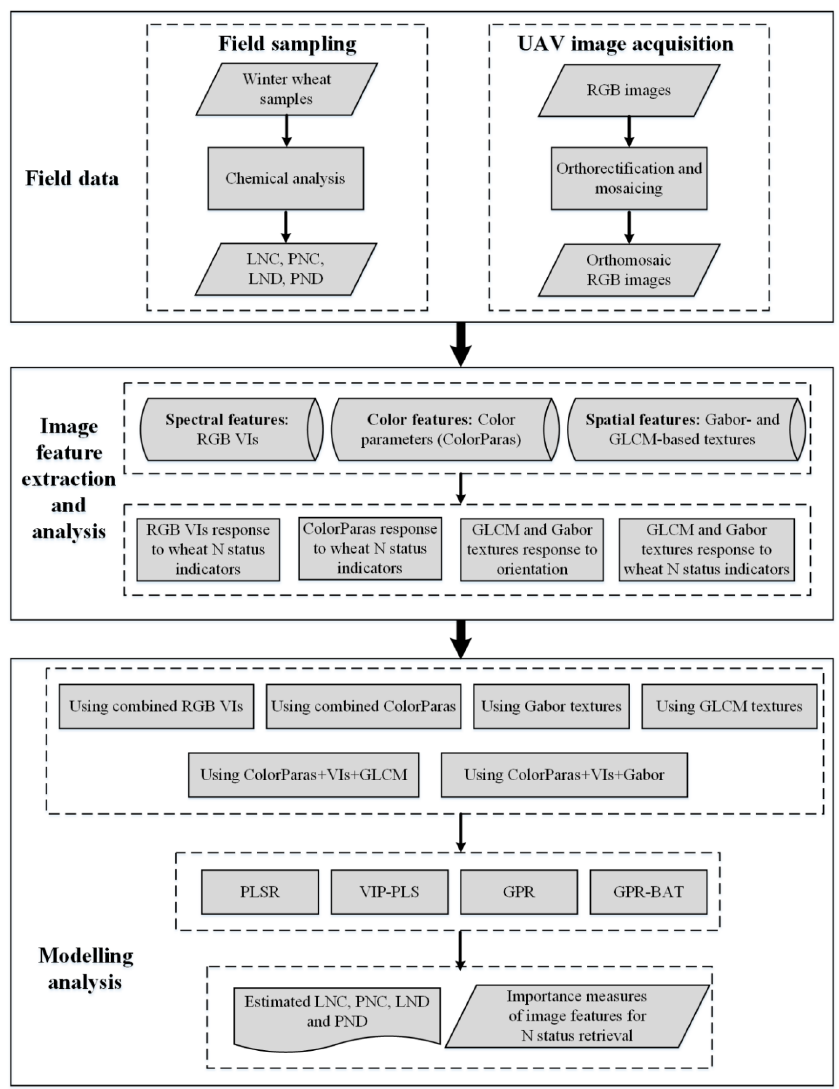
Figure 2. The general workflow of the study.